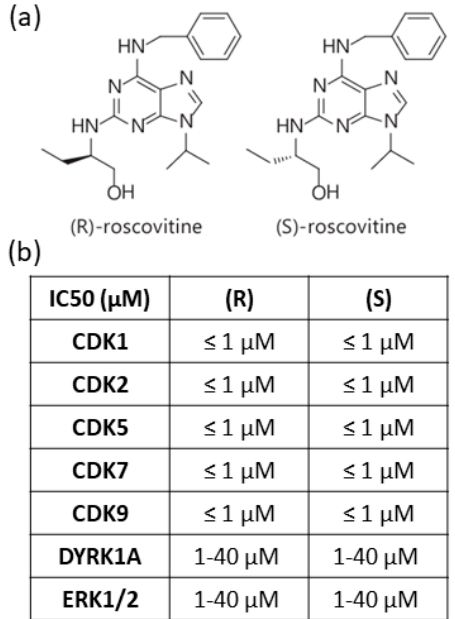
Figure 1. ( R )-roscovitine and ( S )-roscovitine: structure and activity. ( a ) Structure of ( R )- and ( S )- stereoisomer of roscovitine. ( b ) IC50 values (in μ M) described for these compounds.